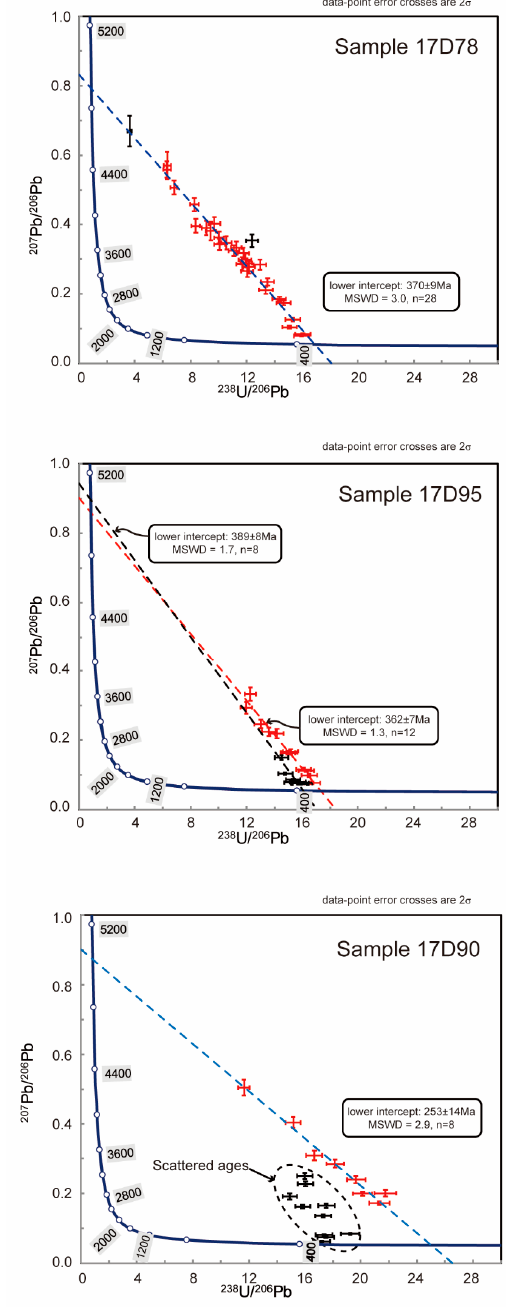
Figure 6. U-Pb concordia diagram of analyzed titanite separated from the garnet clinopyroxenite samples 17D78, 17D95, and 17D90. Data are plotted at 2 σ level, and uncertainties on lower intercept ages are on the 95% confidence.